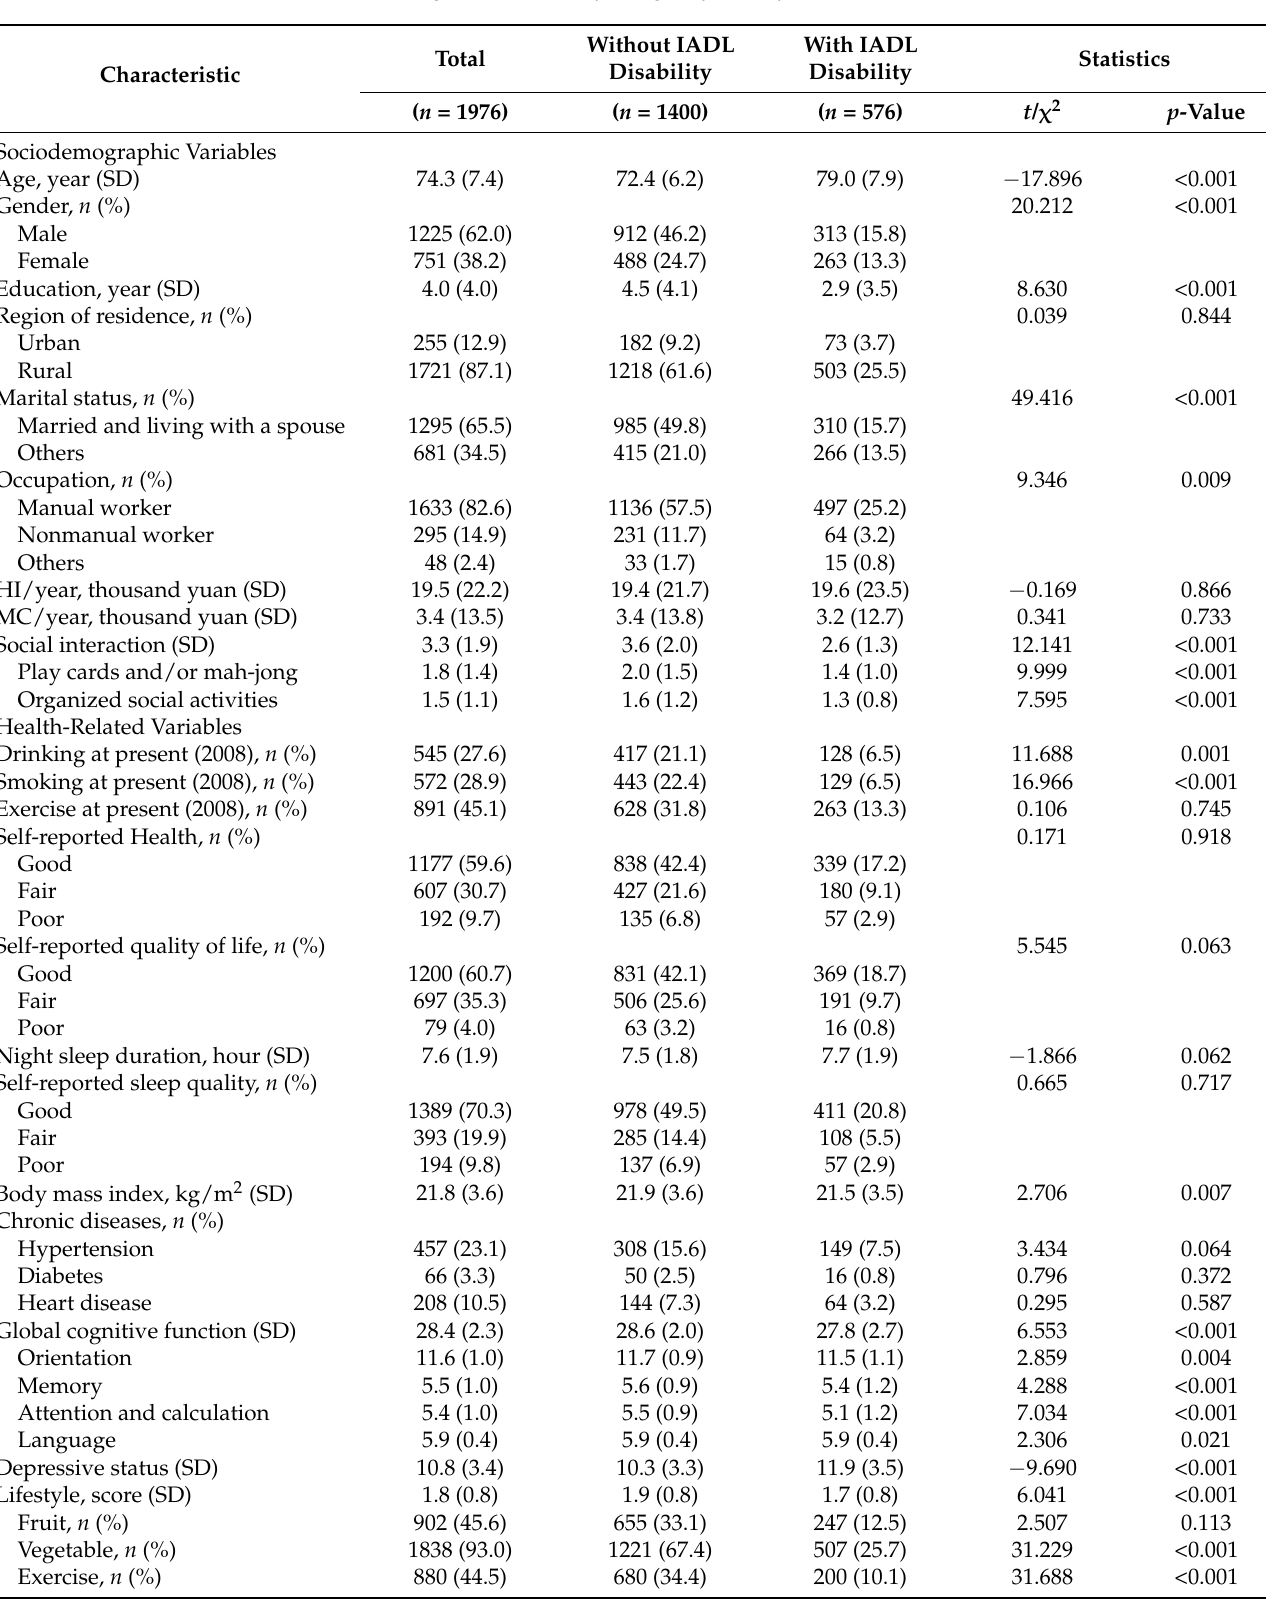
Table 1. Participants’ baseline (2008) characteristics according to IADL disability in 2014, from Chinese Longitudinal Healthy Longevity Surveys